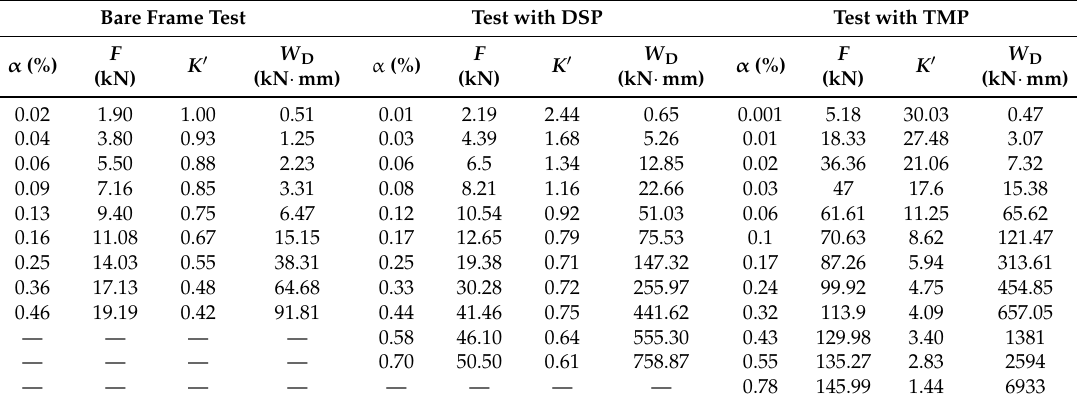
Table 3. Stiffness and energy dissipation of the RC frame with different infilled forms. Bare Frame Test Test with DSP Test with